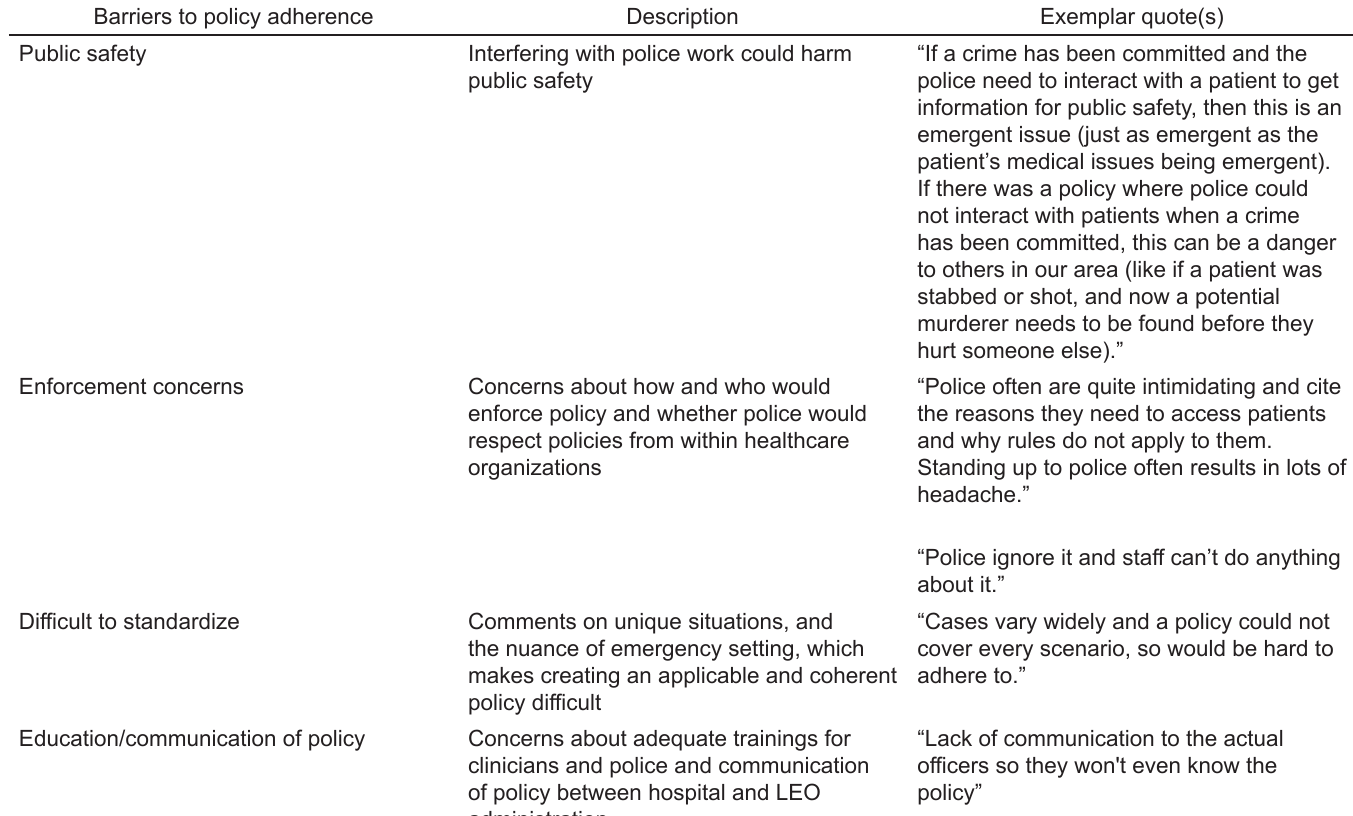
Table 2. Perceived barriers and facilitators to policy